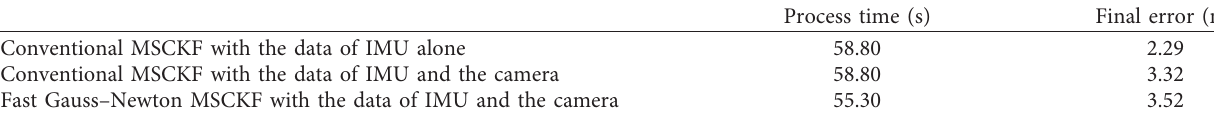
Table 2: The performance of improved MSCKF algorithm with No. 2 datasets.